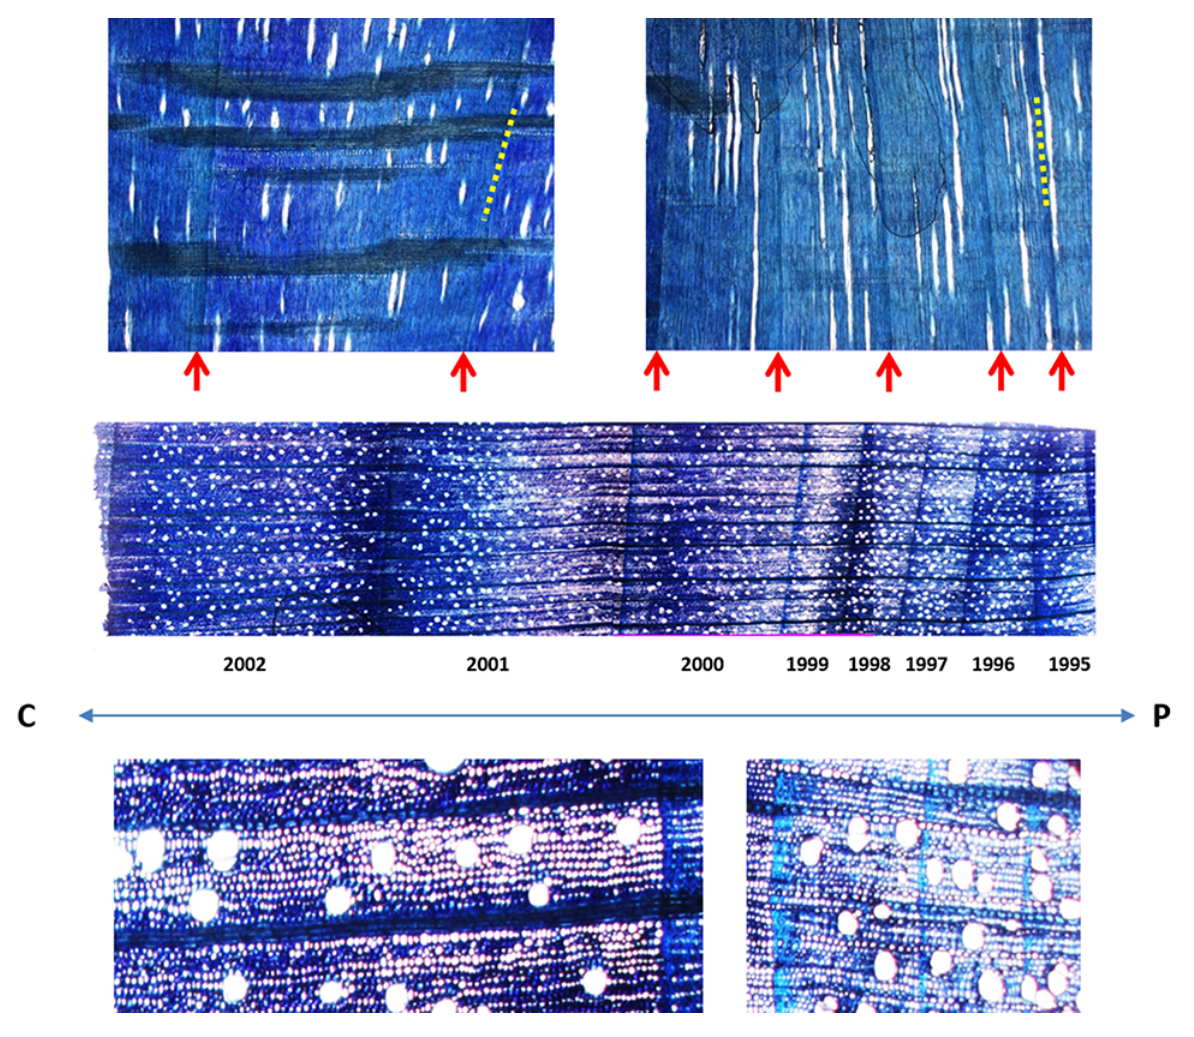
Figure 10 e anatomy of Clethra rippled wood. e transverse section in the middle of the figure shows a transition from thinner to wider annual rings during the past 8 years; an increase in a ring width during the last 3 years led to the formation of a crest; on the radial sections (upper panel) annual ring borders (broken lines and red arrows) tilt towards the pith (p) when annual rings are wide while they tilt towards the cambium (c) in the area of narrower rings of the through. A magnified view of differentiated xylem cells arranged in the radial rows (bottom panel) exposed their similar size but different numbers in wide and narrow rings. e 2002 annual ring width is 6